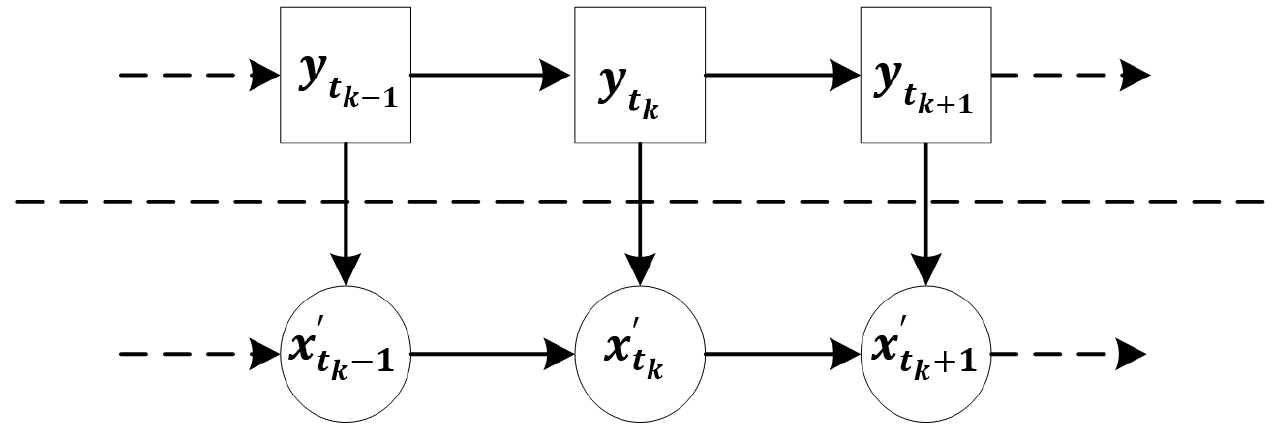
Figure 1. The SSM: y t